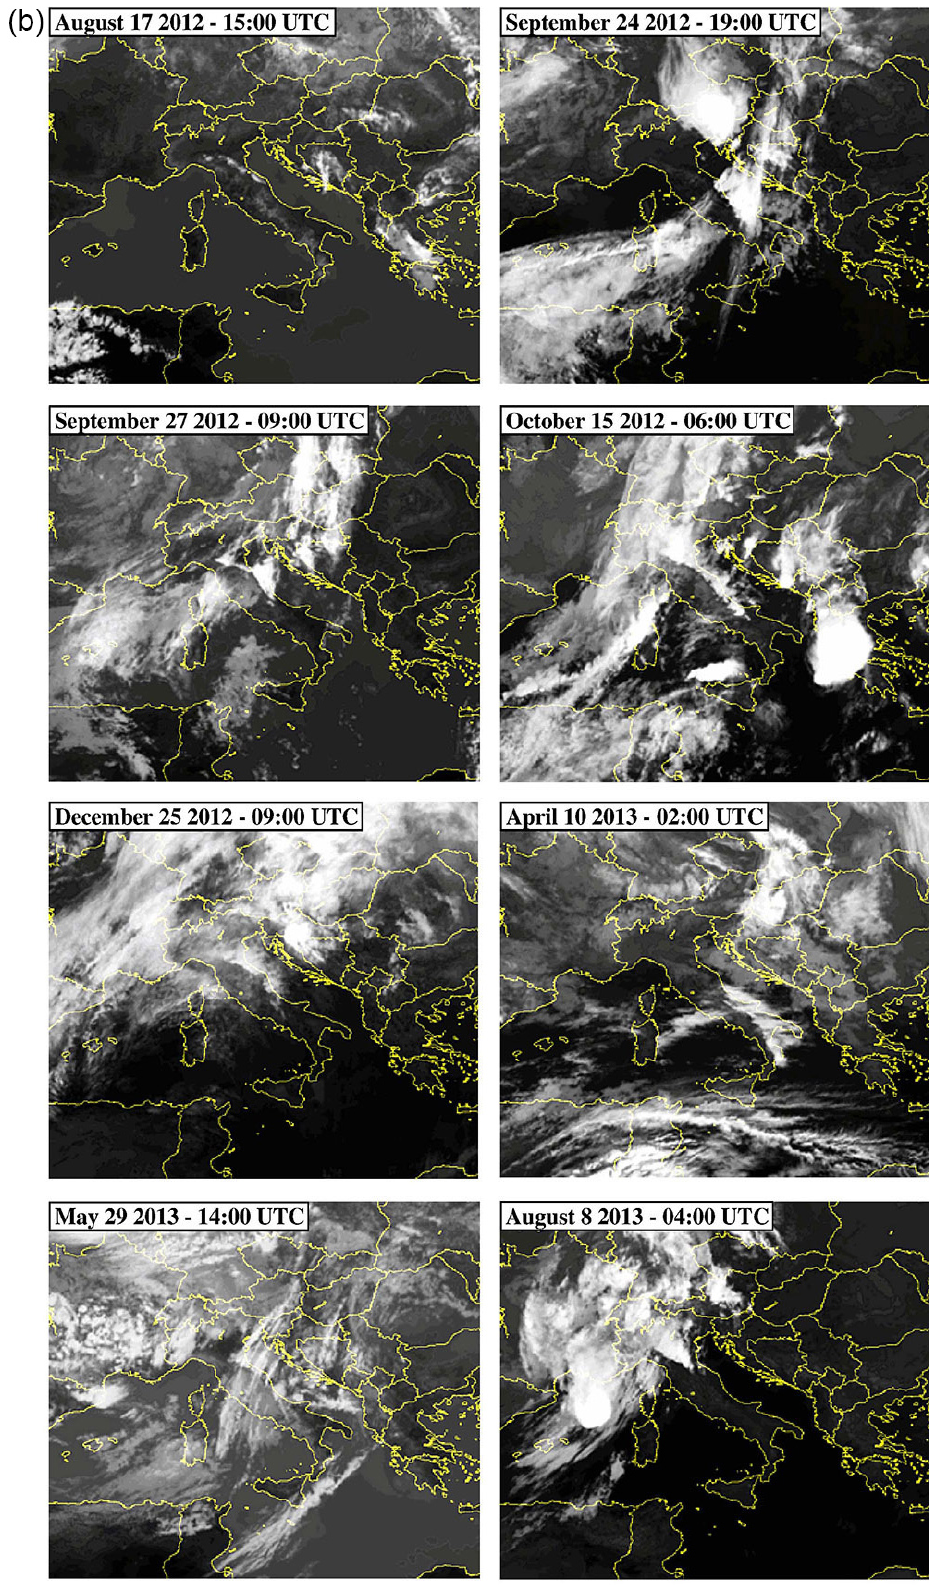
Figure 1. Nat. Hazards Earth Syst. Sci., 15, 1061–1068, 2015